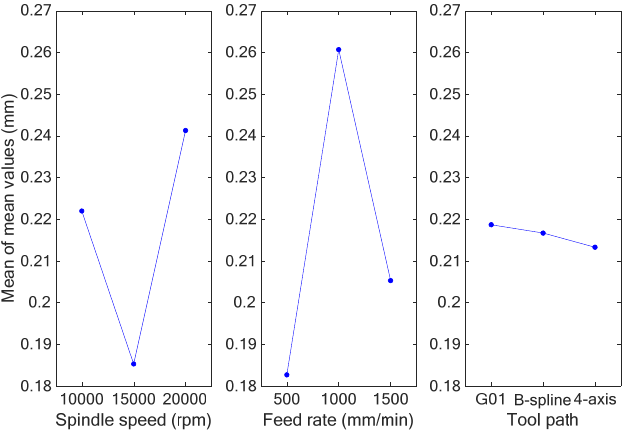
Figure 21. Graph of mean values for surface roughness.